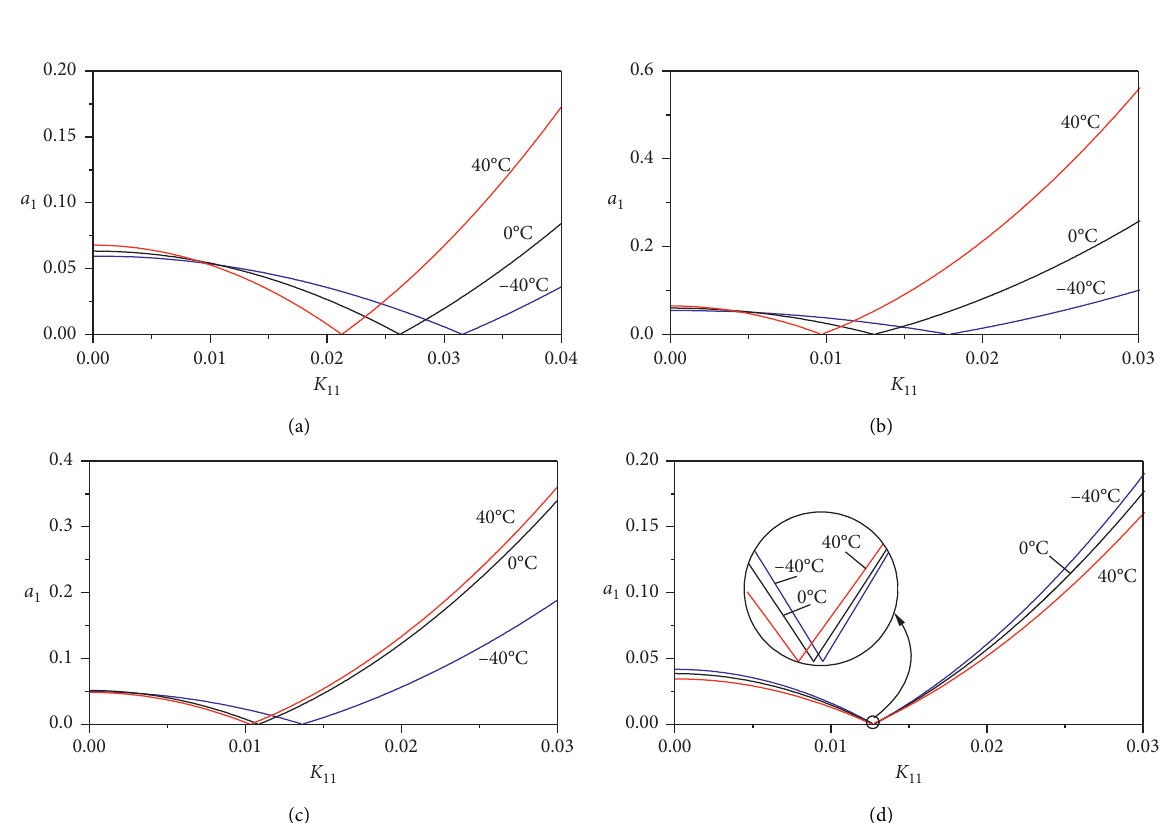
Figure 2: Temperature effects on relationships between excitation amplitude K